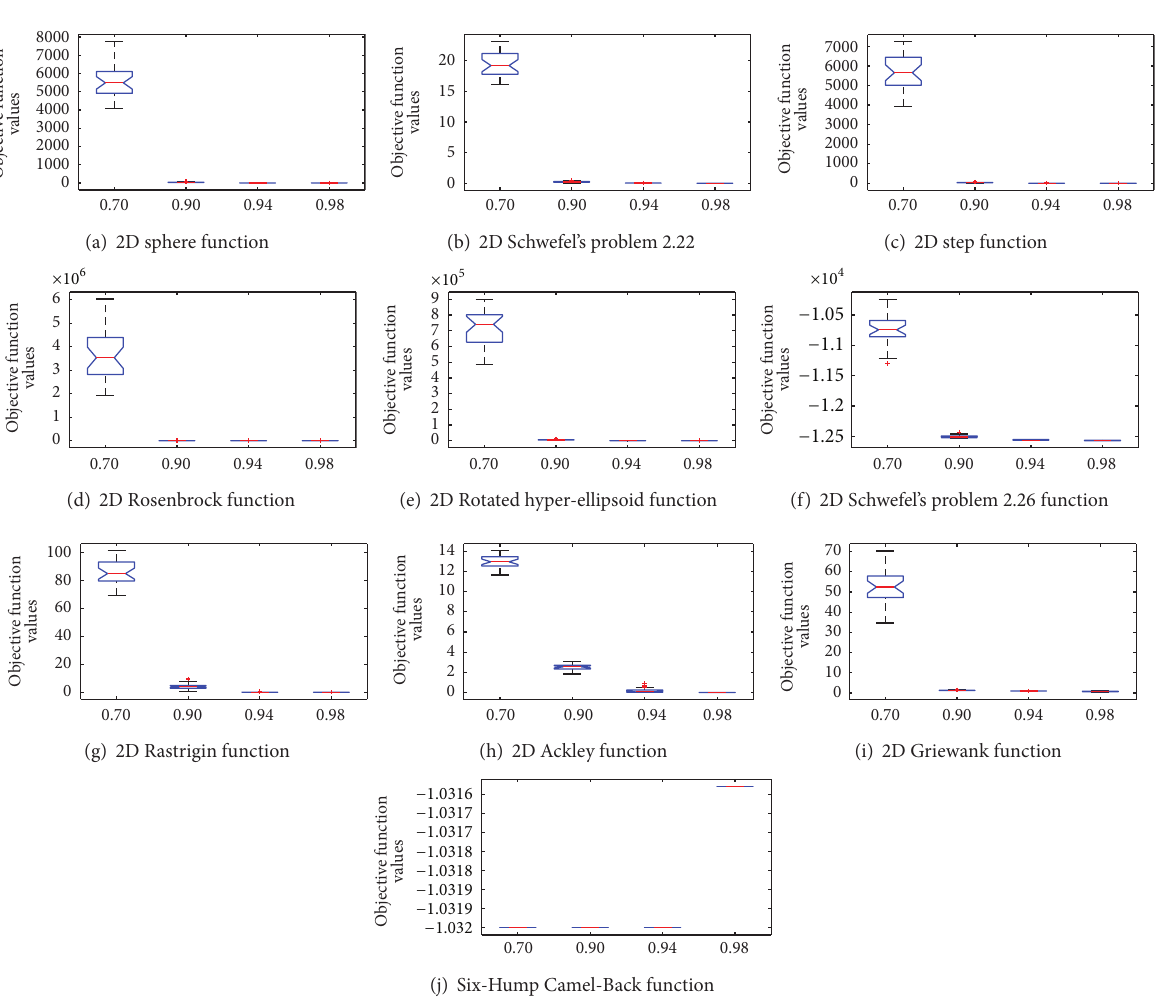
Figure 8: The box plots for showing the effect varying HMCR values using the ten global optimization